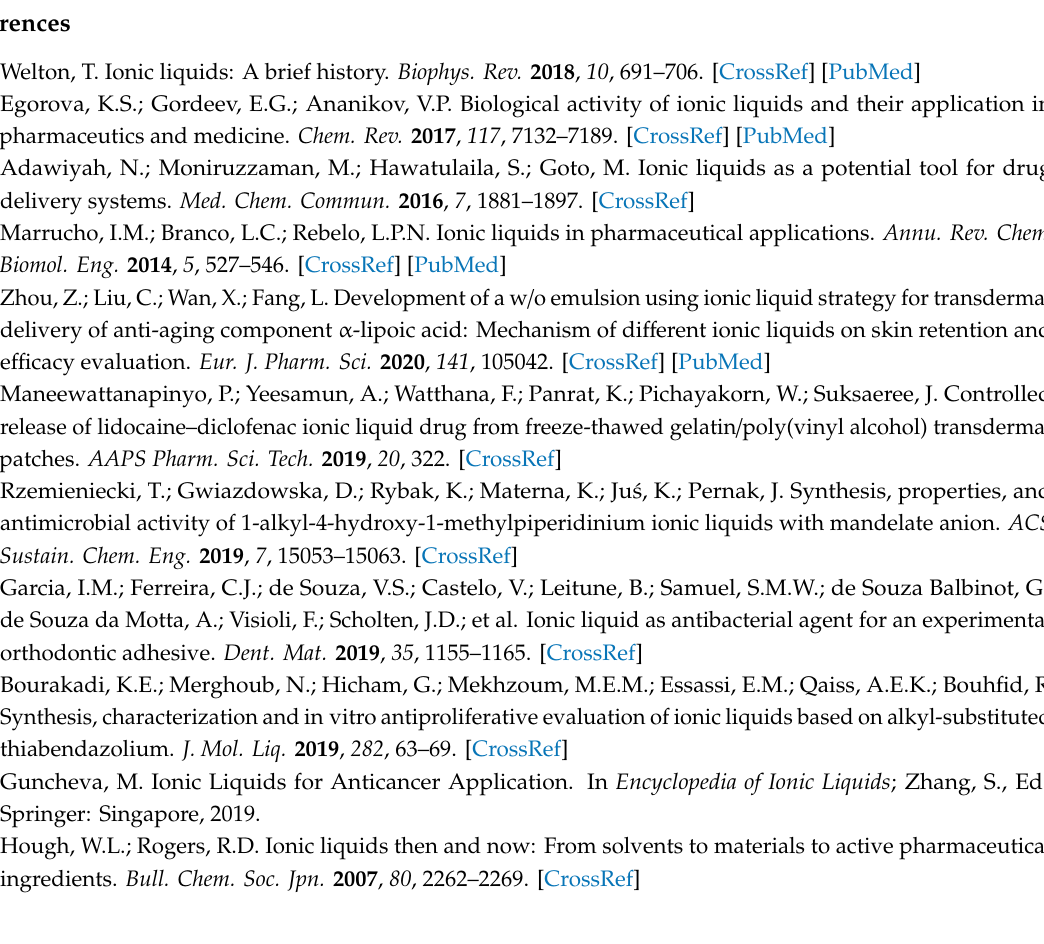
Figure S19: FTIR spectra of [ l -ValOBu][KETO]; Figure S20: FTIR spectra of [KETO], Figure S21:The TG, DTG and c-DTA curves of [ l -LeuOEt][KETO], Figure S22:The TG, DTG and c-DTA curves of [ l -ValOEt][KETO]; Figure S23: The TG, DTG and c-DTA curves of [ l -ValOiPr][KETO], Figure S24:The TG, DTG and c-DTA curves of [ l -ValOPr][KETO], Figure S25: The TG, DTG and c-DTA curves of [ l -ValOBu][KETO], Figure S26:The TG, DTG and c-DTA curves of [KETO], Figure S27: The DSC curves of [ l -LeuOEt][KETO], Figure S28: The DSC curves of [ l -ValOEt][KETO], Figure S29: The DSC curves of [ l -ValOiPr][KETO], Figure S30: The DSC curves of [ l -ValOPr][KETO], Figure S31: The DSC curves of [ l -ValOBu][KETO], Figure S32: The DSC curves of [KETO], Figure S33: The plot of log (Fo − F) / F vs log. [Q] at 25 ◦ C, where Q is ketoprofen (A); [ l -LeuOEt][KETO] (B); [ l -ValOEt][KETO] (C); [ l -ValOiPr][KETO] (D) [ l -ValOPr][KETO] (E) and [ l -ValOBu][KETO] (F), Figure S34: The original (a), second derivative and deconvoluted ATR-FTIR spectra in Amide I region of native BSA in PBS bu ff er (pH 7.4, 50 mM) at concentration of 20 mg L − 1 , Figure S35: The original (a), second derivative and deconvoluted ATR-FTIR spectra in Amide I and Amide II region of native BSA-ketoprofen (1:1) in PBS bu ff er (pH 7.4, 50 mM), Figure S36: The original (a), second derivative and deconvoluted ATR-FTIR spectra in Amide I and Amide II region of native BSA-[ l -LeuOEt][KETO] (1:1) in PBS bu ff er (pH 7.4, 50 mM), Figure S37: The original (a), second derivative and deconvoluted ATR-FTIR spectra in Amide I and Amide II region of native BSA-[ l -ValOEt][KETO] (1:1) in PBS bu ff er (pH 7.4, 50 mM), Figure S38: The original (a), second derivative and deconvoluted ATR-FTIR spectra in Amide I and Amide II region of native BSA-[ l -ValOiPr][KETO] (1:1) in PBS bu ff er (pH 7.4, 50 mM), Figure S39: The original (a), second derivative and deconvoluted ATR-FTIR spectra in Amide I and Amide II region of native BSA-[ l -ValOPr][KETO] (1:1) in PBS bu ff er (pH 7.4, 50 mM), Figure S40: The original (a), second derivative and deconvoluted ATR-FTIR spectra in Amide I and Amide II region of native BSA-[ l -ValOBu][KETO] (1:1) in PBS bu ff er (pH 7.4, 50